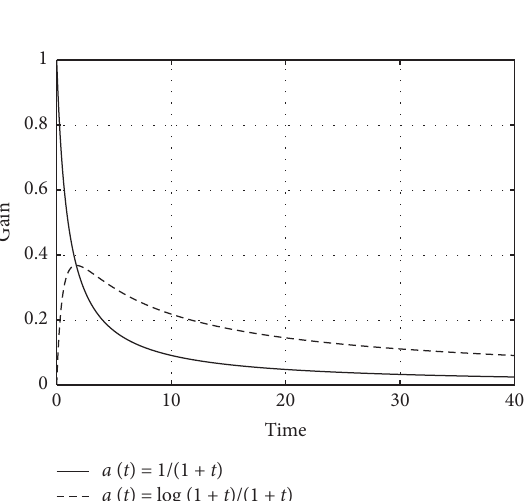
Figure 6: States of agents with large noise.